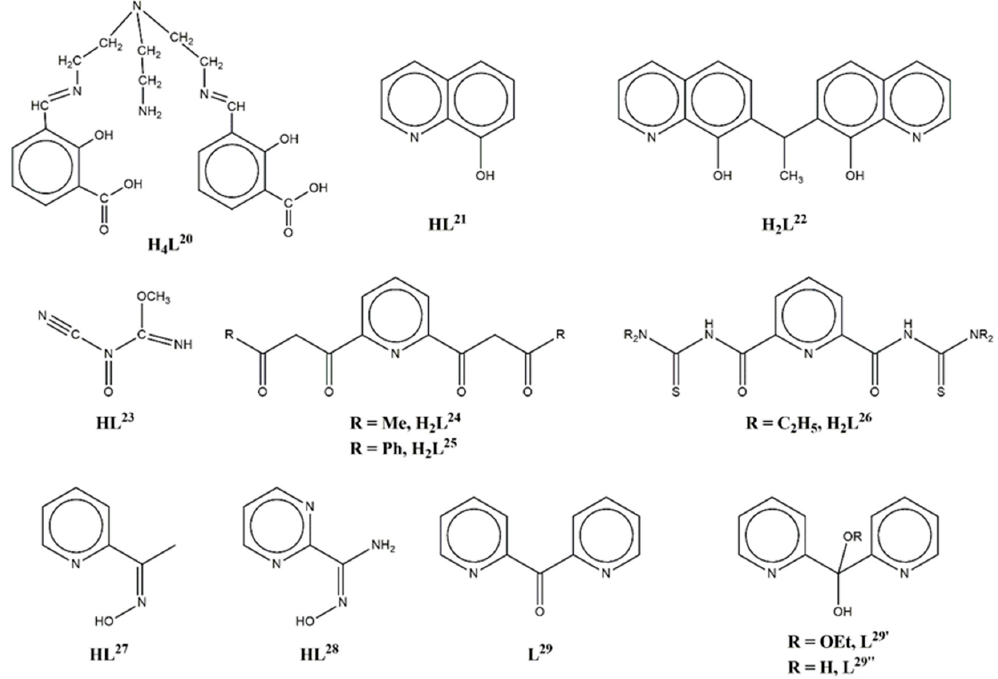
Scheme 3. The ligands used in the Ni 2 Ln complexes 94 – 145 .